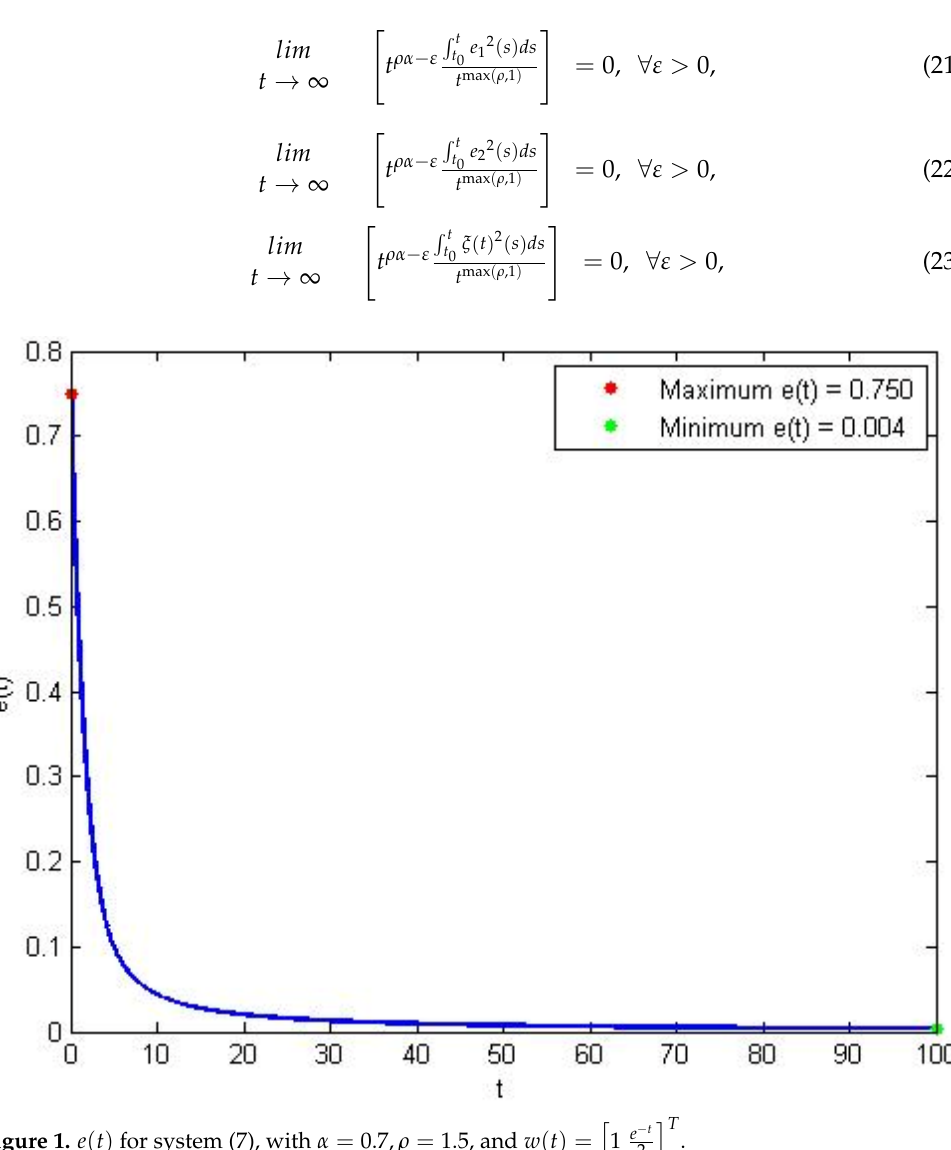
Figure 1. e ( t ) for system (7), with α = 0.7, ρ = 1.5, and w ( t ) = Figure 1. 𝑒(𝑡) for system (7), with 𝛼 = 0.7, 𝜌 = 1.5, and 𝑤(𝑡) = [1